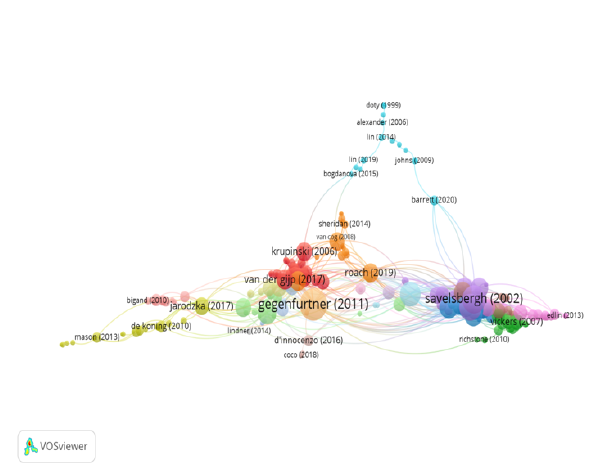
Figure 7. Citation network in Group 5